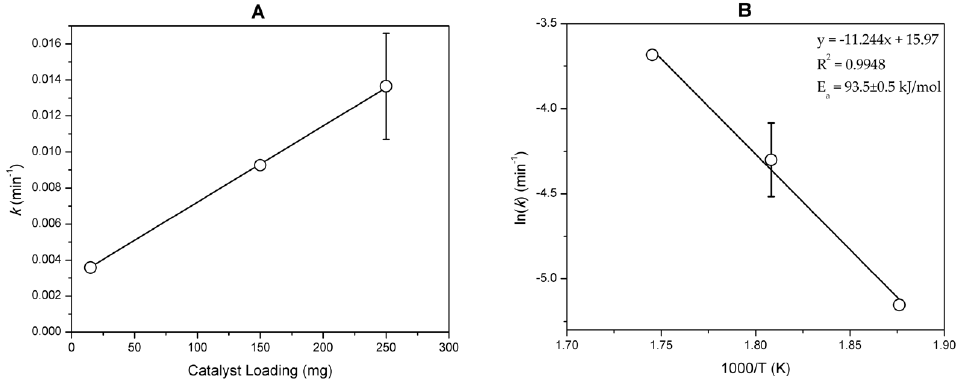
Figure 7. Variation of the ( A ) catalyst loading (T = 280 ° C) showing first-order behavior for the disappearance of stearic acid compared to the catalyst loading and the ( B ) temperature (loading = 250 mg) showing Arrhenius behavior for increasing temperatures. Error bars are the range about the average of the two data points collected at 250 mg catalyst and T = 280 ° C.